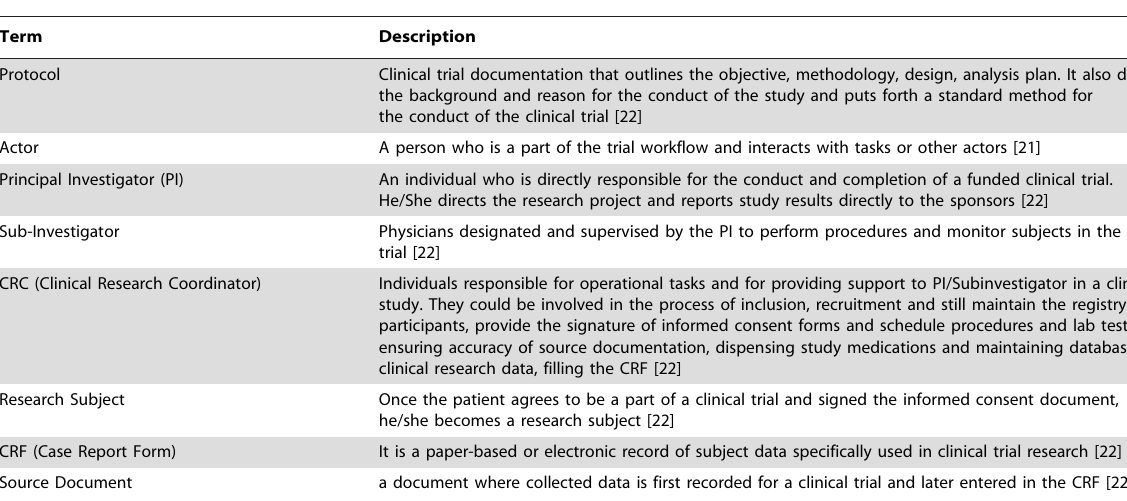
Table 1. Terminology standardization.